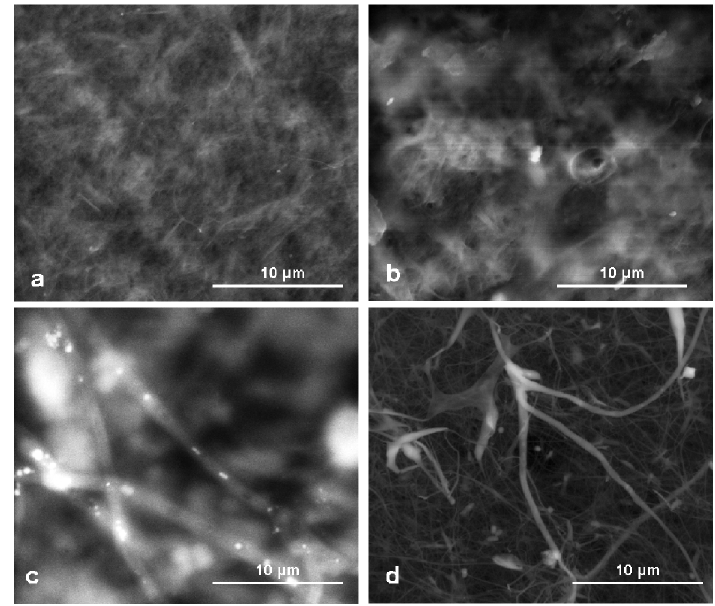
Figure 6. SEM images of lyophilized BC (a), BC/HC composite (b), BC/CS composite (c) and BC/CG composite (d).